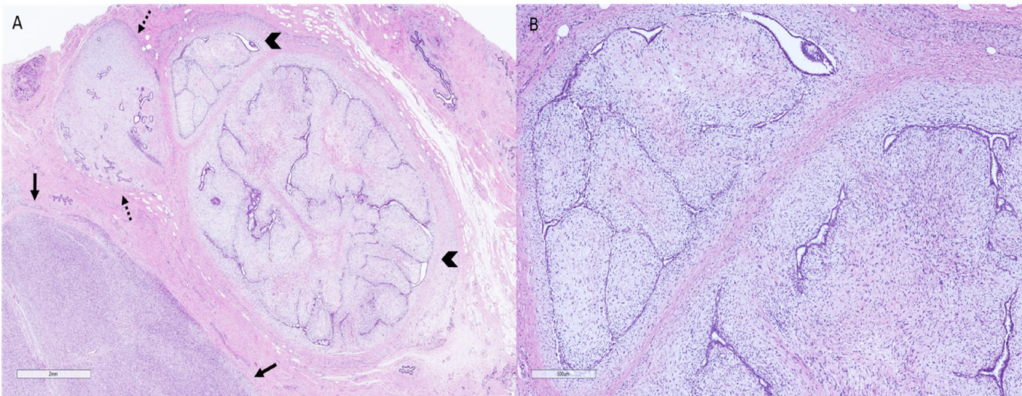
Figure 1. Surgical specimen of a patient diagnosed with a malignant phyllodes tumor displaying areas with benign, borderline, and malignant features. ( A ): Representative micrograph of the excision specimen showing a heterogeneous lesion with areas of marked (arrows), moderate (dotted arrows), and mild (arrowheads) stromal cellularity (hematoxylin– eosin, original magnification 10 × ). ( B ): Representative micrograph of an area of the same neoplasm and specimen exhibiting an intracanalicular growth pattern, low stromal cellularity, and no cytologic atypia (hematoxylin–eosin, original magnification 50 ×